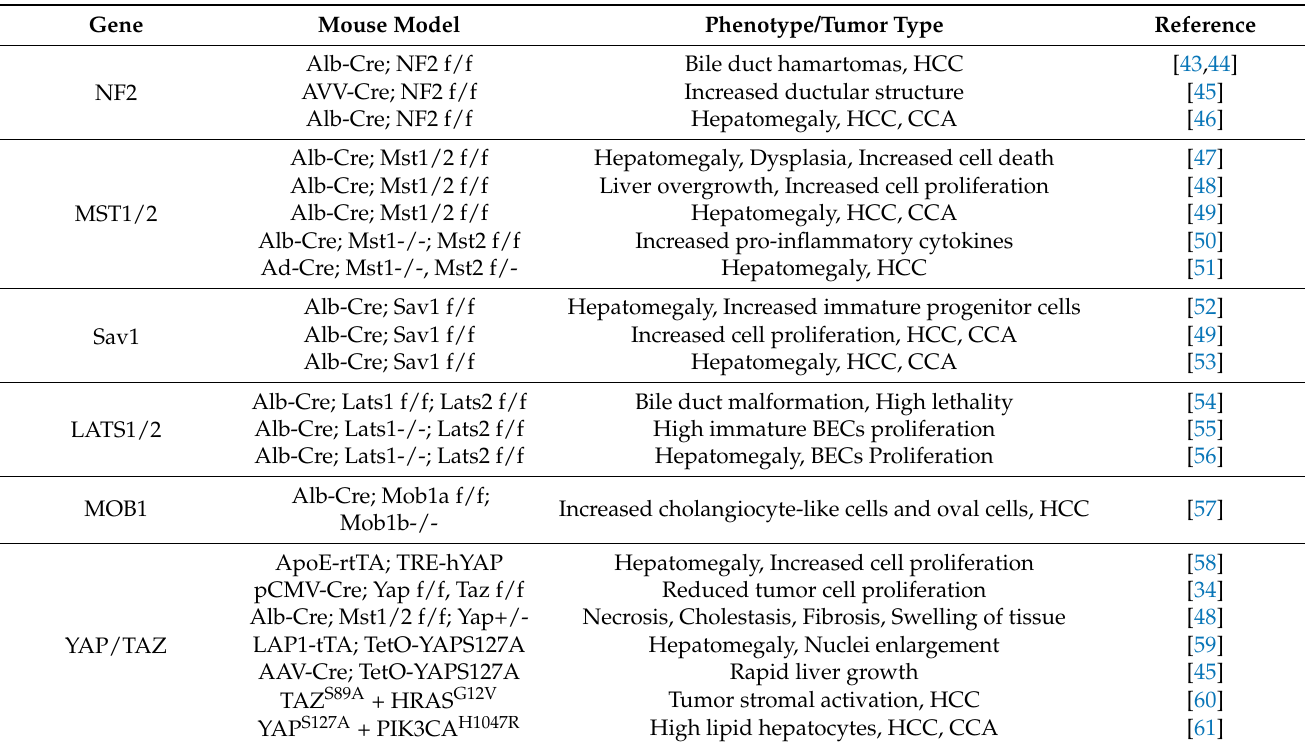
Table 1. Genetically engineered mouse models with dysregulated Hippo-YAP/TAZ